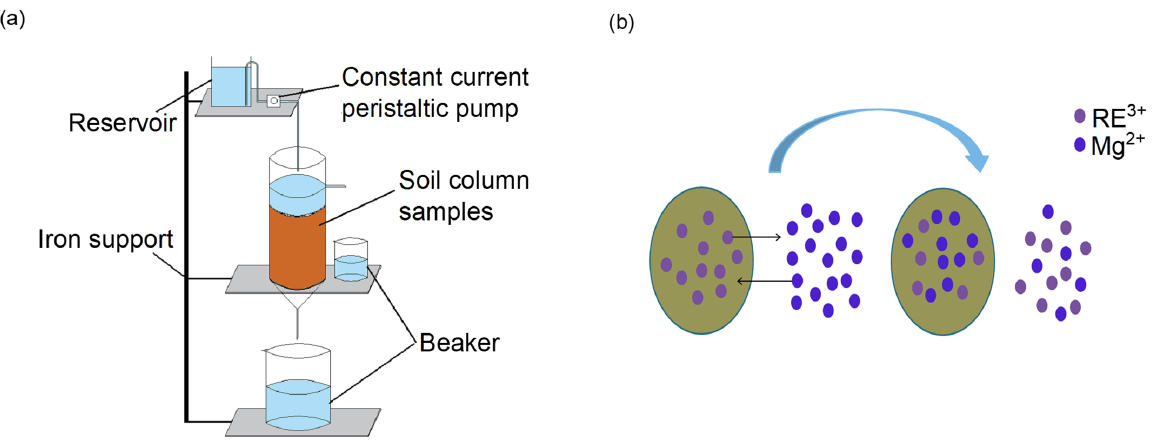
Figure 2. ( a ) Schematic diagram of experimental setup; ( b ) Rare earth leaching schematic.